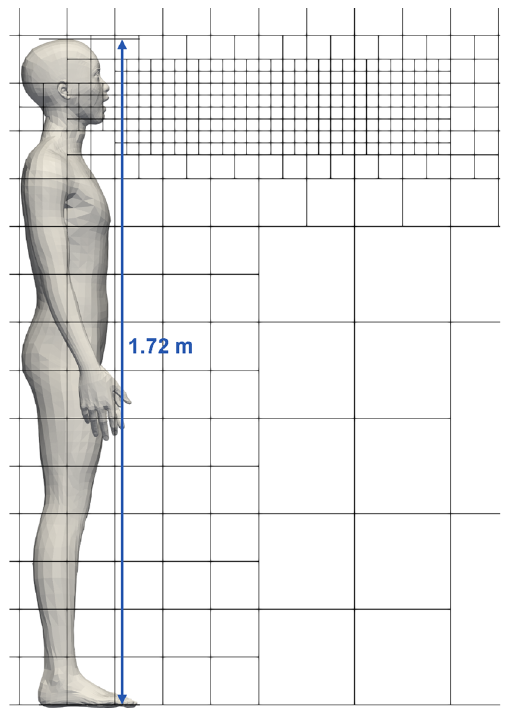
Figure 3. Blocks of the numerical mesh employed in the present study. Subdivision of the blocks into 16 equal parts along each direction produces the